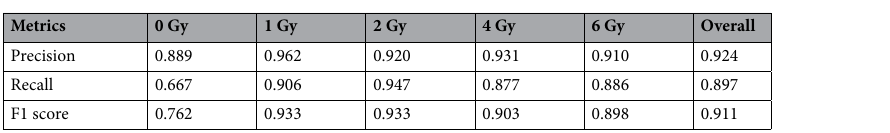
Table 1. γ-H2AX foci detection model evaluation. Performance metrics by dose for precision, recall and F1 score.